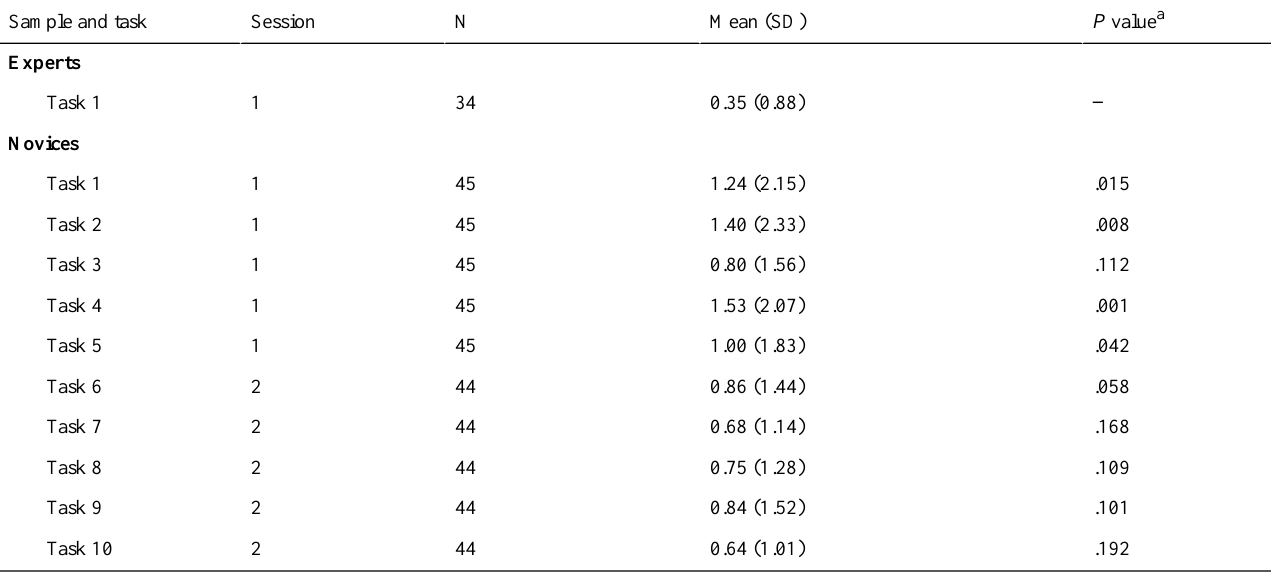
Table 6. Comparisons between the errors of experts for the first task of Session 1 and those of novices at each task.